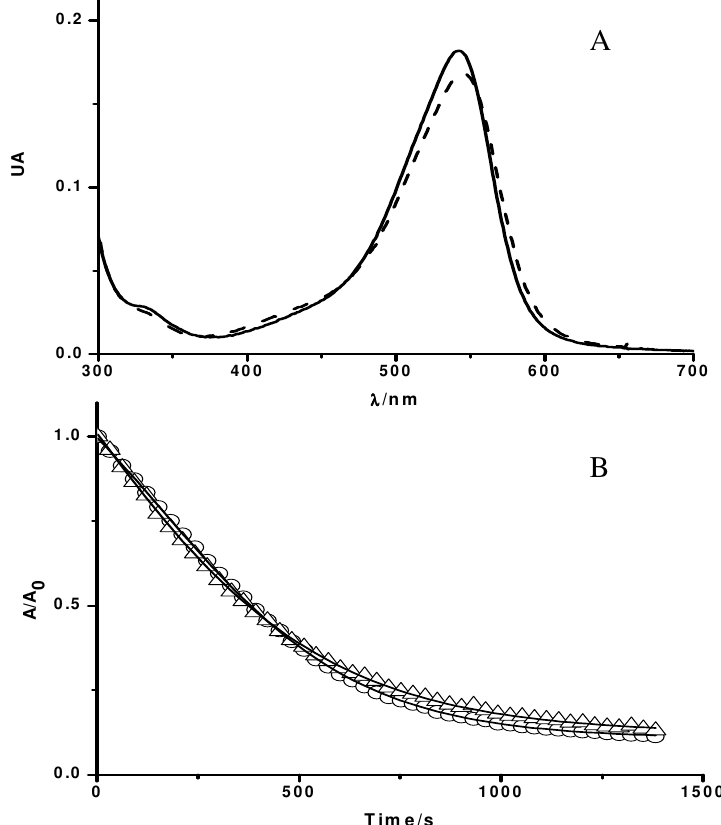
Figure 1. Influence of Triton X-100 micelles on the UV-visible spectrum of PGR ( A ) and its consumption mediated by peroxyl radicals ( B ). A : UV-visible spectrum of PGR (5 µM) in phosphate buffer (75 mM, pH 7.4, solid line), and in the presence of Triton X-100 (50 mM) (dashed line); B : Time-course of the consumption of PGR induced by AAPH derived peroxyl radicals in the absence and presence of Triton X-100 micelles. PGR (5 µM) was incubated in phosphate buffer (75 mM, pH 7.4) at 37 °C with AAPH (10 mM) in the absence ( (cid:1) ), and presence of Triton X-100 (50 mM, (cid:1)